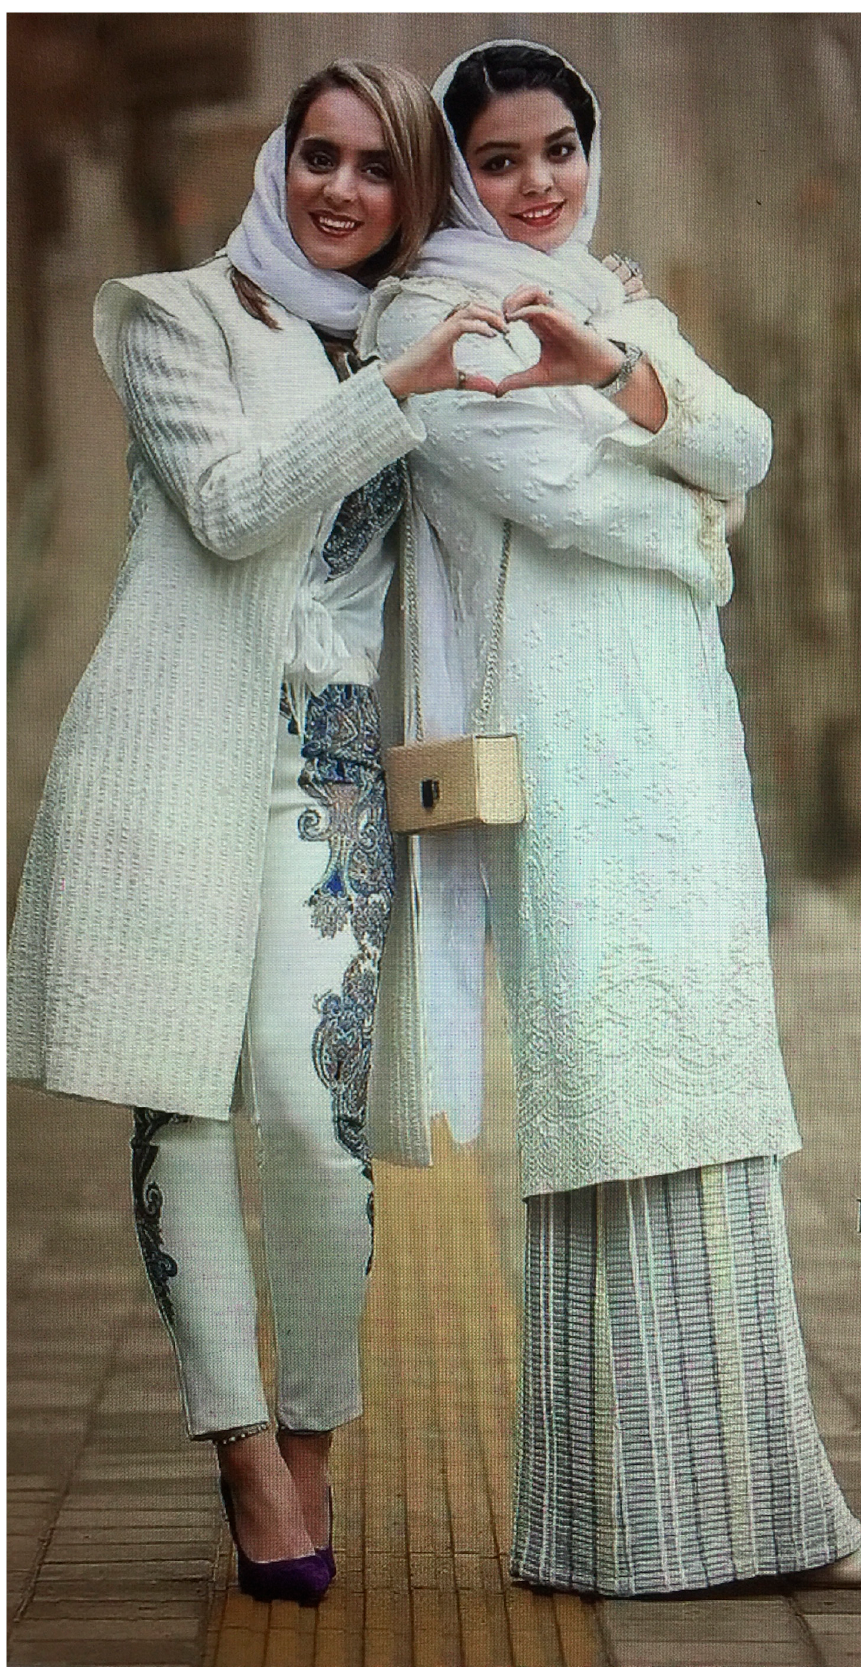
Figure 15. Modern fashion daywear in Iran- Designer: Behi Bahar Source: https://www.tasvirezendegi.com.